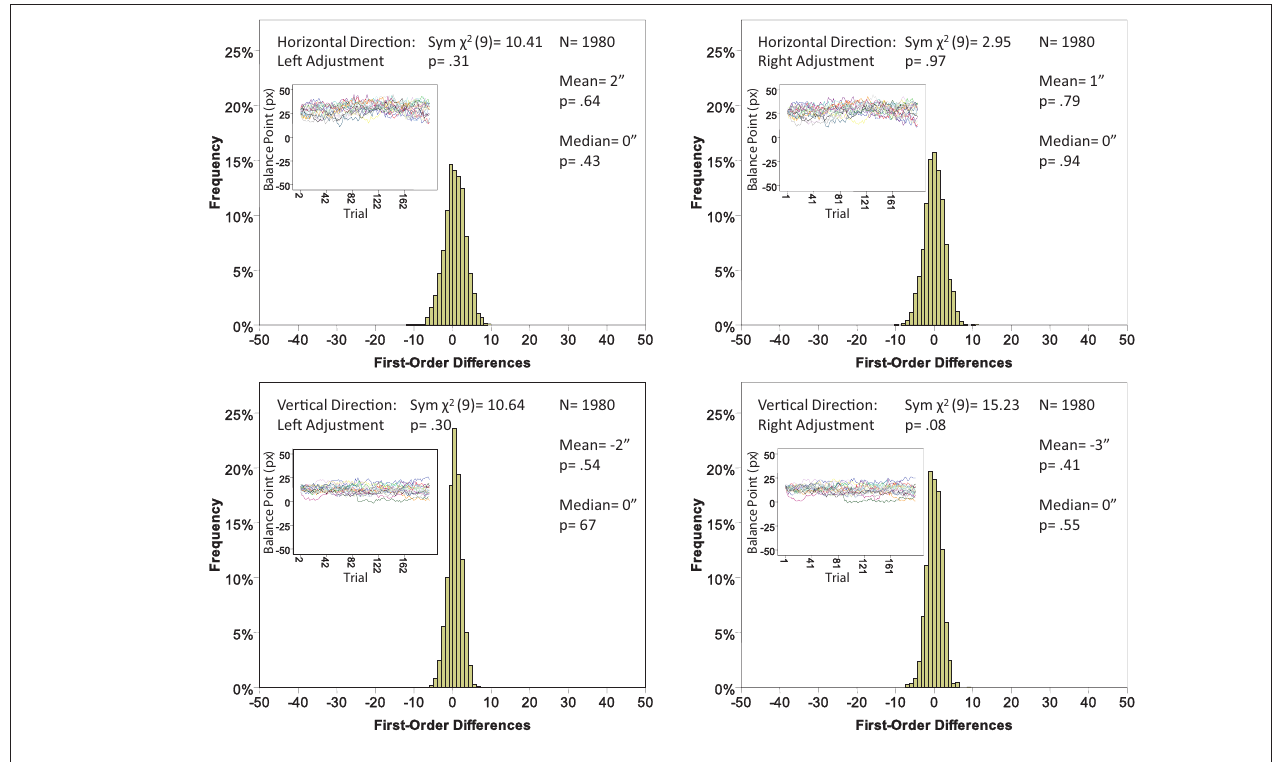
Figure 9 | Histograms of the ∆ ’s for the location experiment, participant P2. The rest as in Figure 7 .